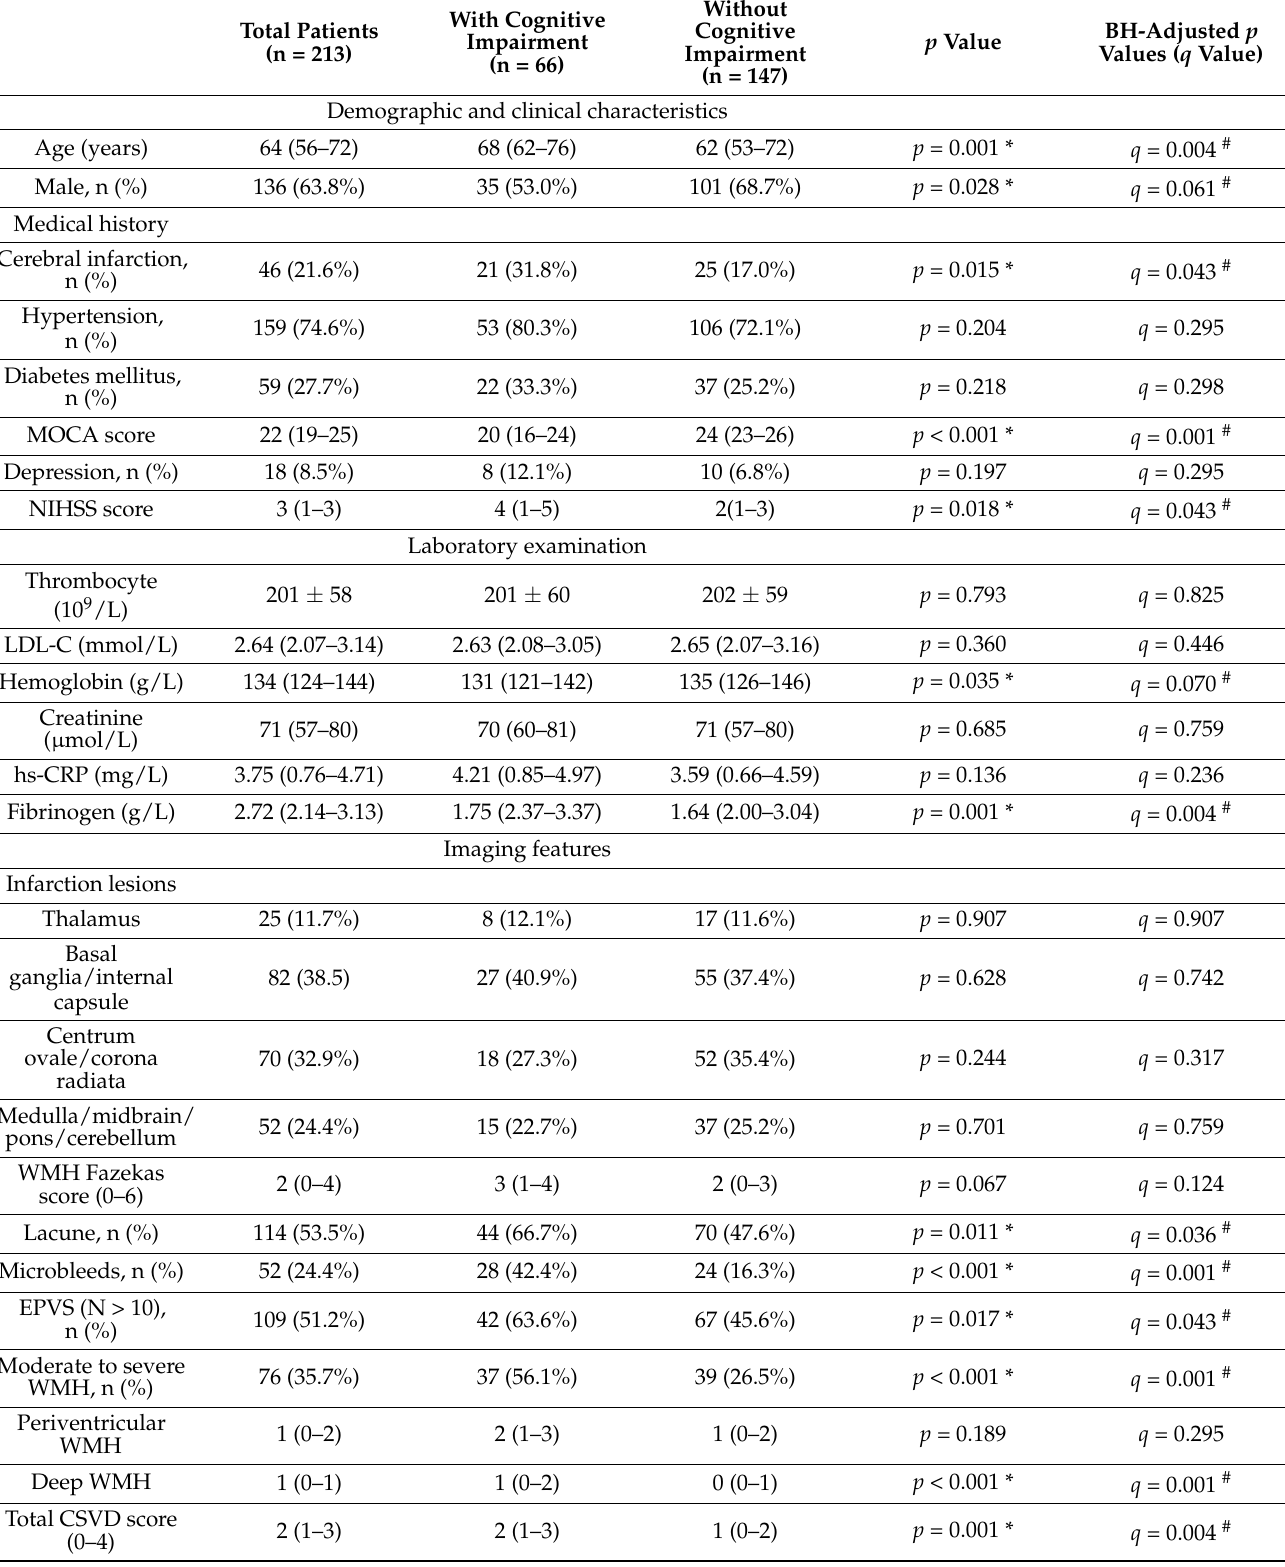
Table 1. Demographic, clinical and CSVD characteristics of